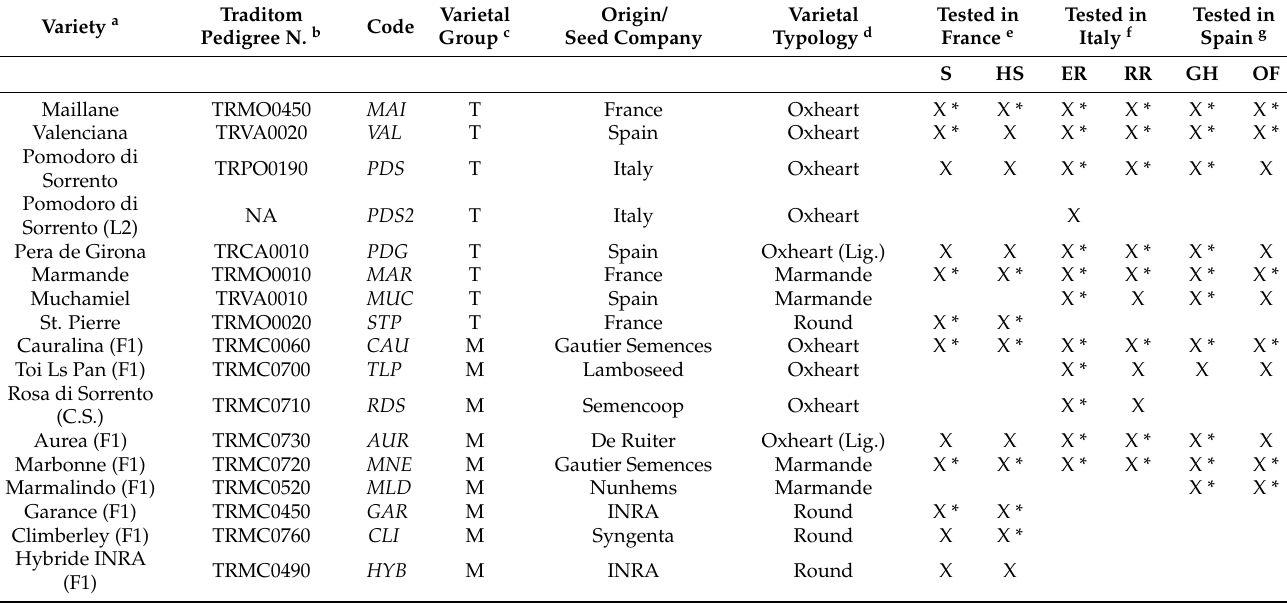
Table 1. List of fresh market tomato varieties (Traditional and Modern counterparts) analyzed by trained and consumer panels in each country and in different growing conditions or ripening stages. Variety a